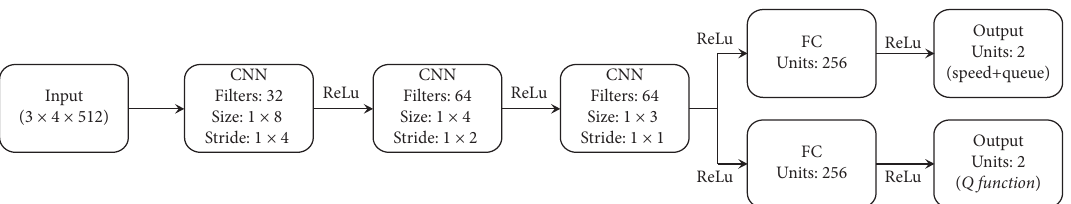
Figure 7: Structure of the deep neural